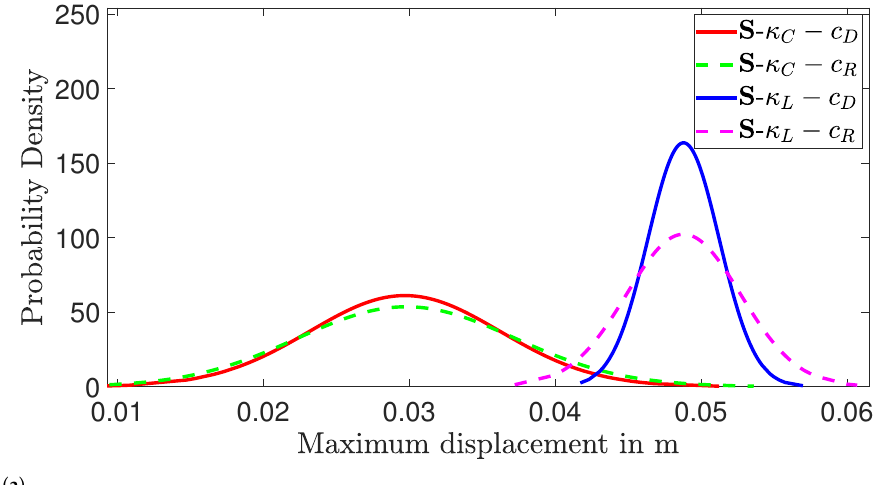
, h , h respectively. 6 3 12